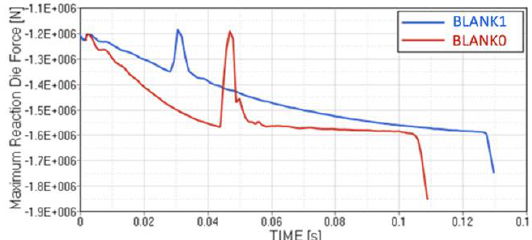
Figure 29. Die reaction force comparison for both simulation plans.